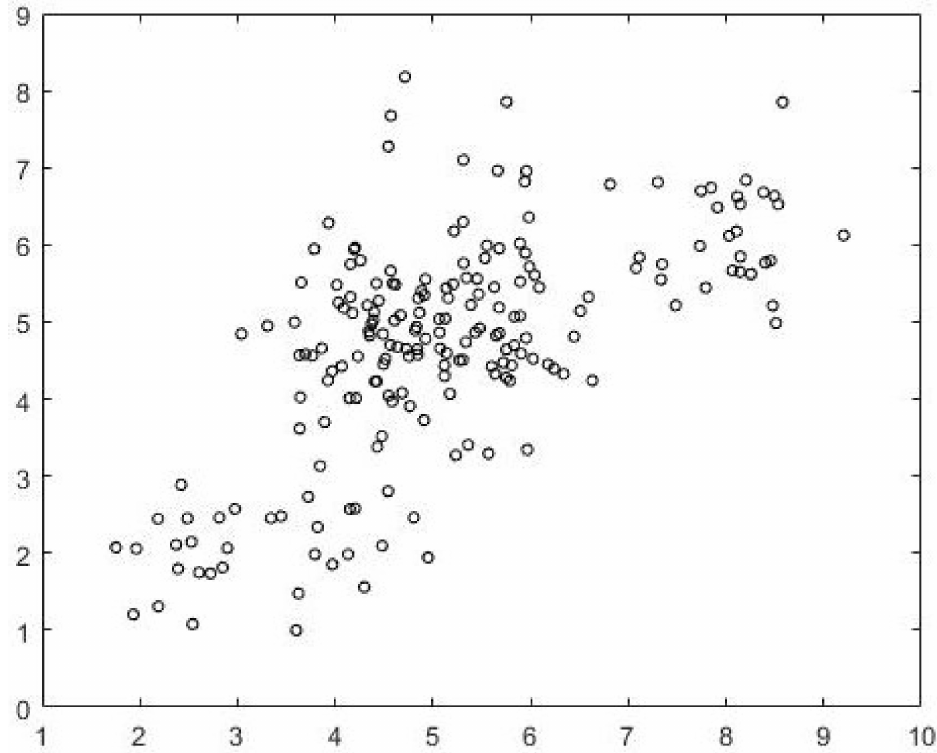
Figure 6. Best subset of Data2 using sparse sampling ( n = 200, H = 0.9025).